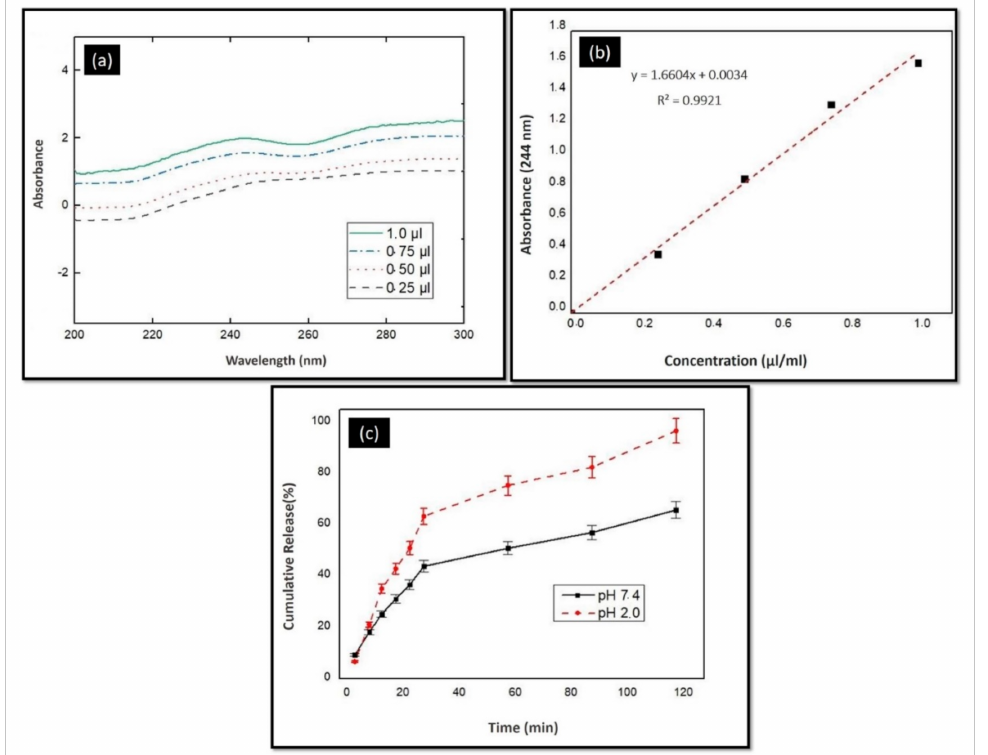
Figure 2. ( a ) Absorbance values according to di ff erent dilution ratios for the standard calibration curve. ( b ) Standard calibration curve of Ps solution. ( c ) Release profile of 3D-printed Ps-incorporated SA sca ff olds in di ff erent pH